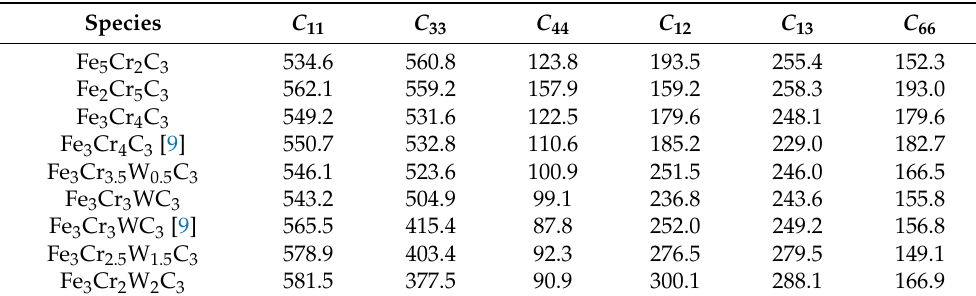
Table 2. The elastic constants ( C ij , GPa) of different M 7 C 3 carbides.